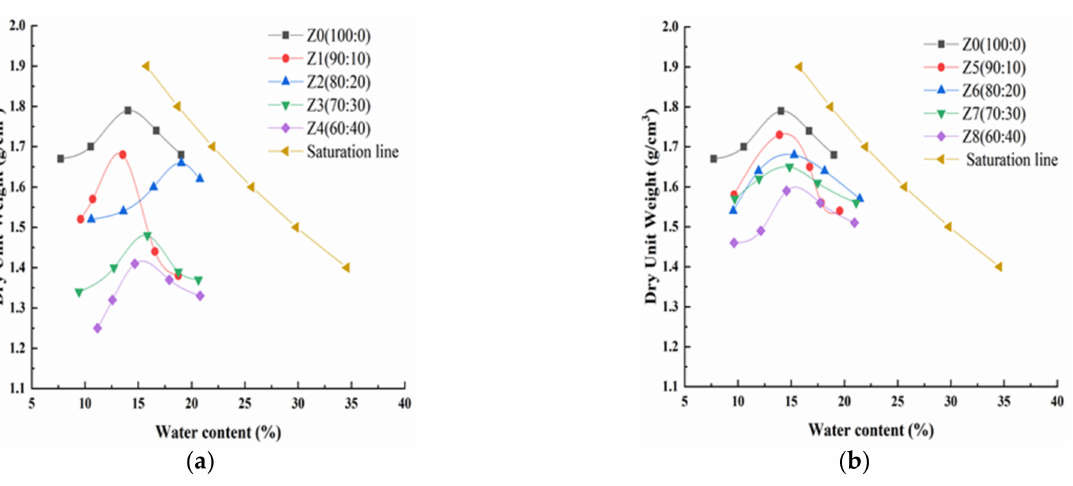
Figure 3. Compaction curves of the loess modified by different solidified materials. ( a ) Desulfuriza- tion ash; and ( b ) fly ash.